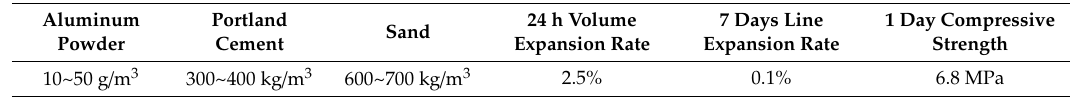
Table 1. Properties of CAM-I dry materials.